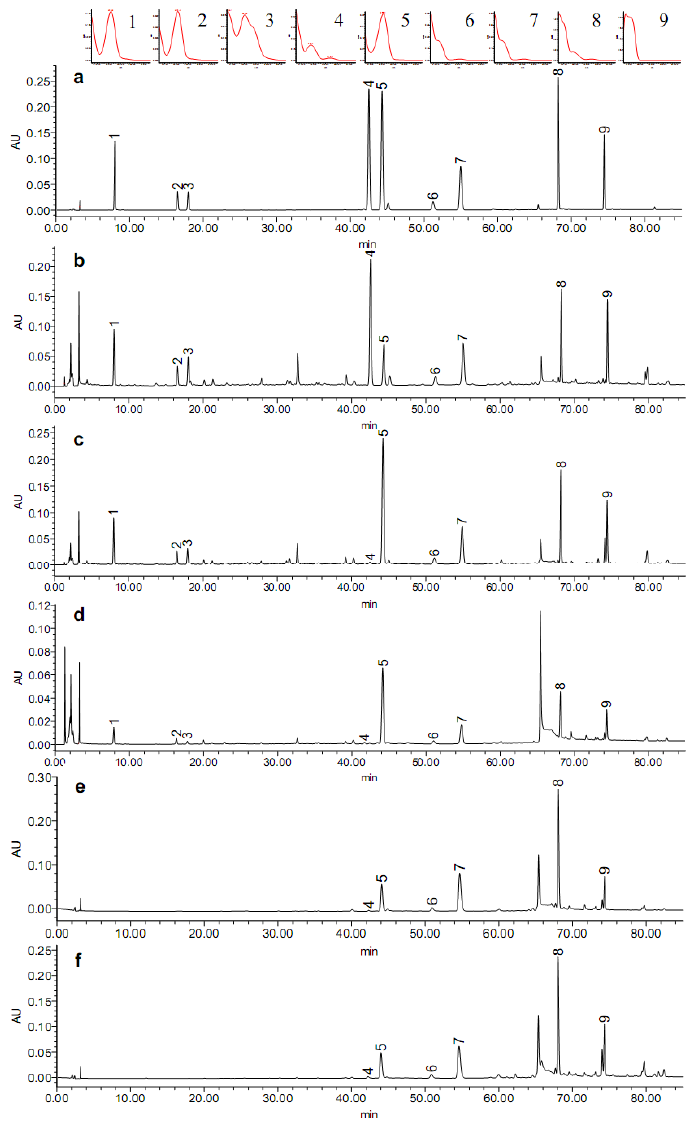
Figure 2. Representative HPLC profiles of the samples of C. wenyujin and mixed sesquiterpene standards. ( a ) Mixed sesquiterpene reference standards and their UV spectra; ( b ) the sample of PJH; ( c ) the sample of WEZ; ( d ) the sample of WYJ; ( e ) the essential oil of C. wenyujin , and ( f ) commercial sample of suppositories (Fufang Ezhuyou) at 244 nm. (1-zedoarondiol, 2-isozedoarondiol, 3-aerugidiol, 4-(4 S ,5 S )-germacrone-4,5-epoxide, 5-curcumenone, 6-neocurdione, 7-curdione, 8-germacrone,